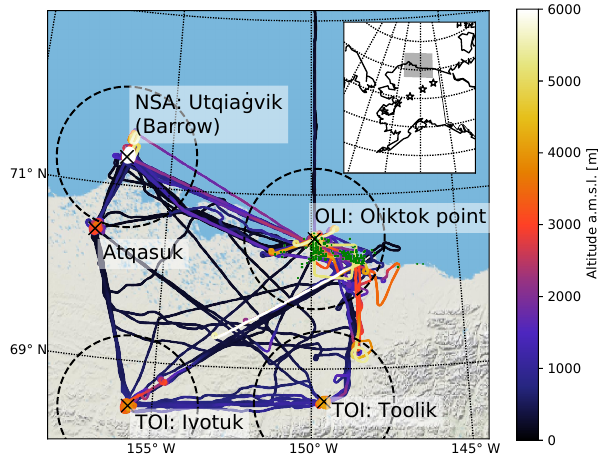
Figure 1. Overview of all flights of the ACME-V campaign. Colour shows altitude above mean sea level. The dashed circles indicate 90km radii around the sites (black crosses), the green dots indi- cate active oil wells (data obtained from http://doa.alaska.gov/ogc/ publicdb.html in March 2017). The grey inset shows the location of the region in Alaska and the five assumed sources for forest fire emissions (stars) based on MODIS thermal anomaly